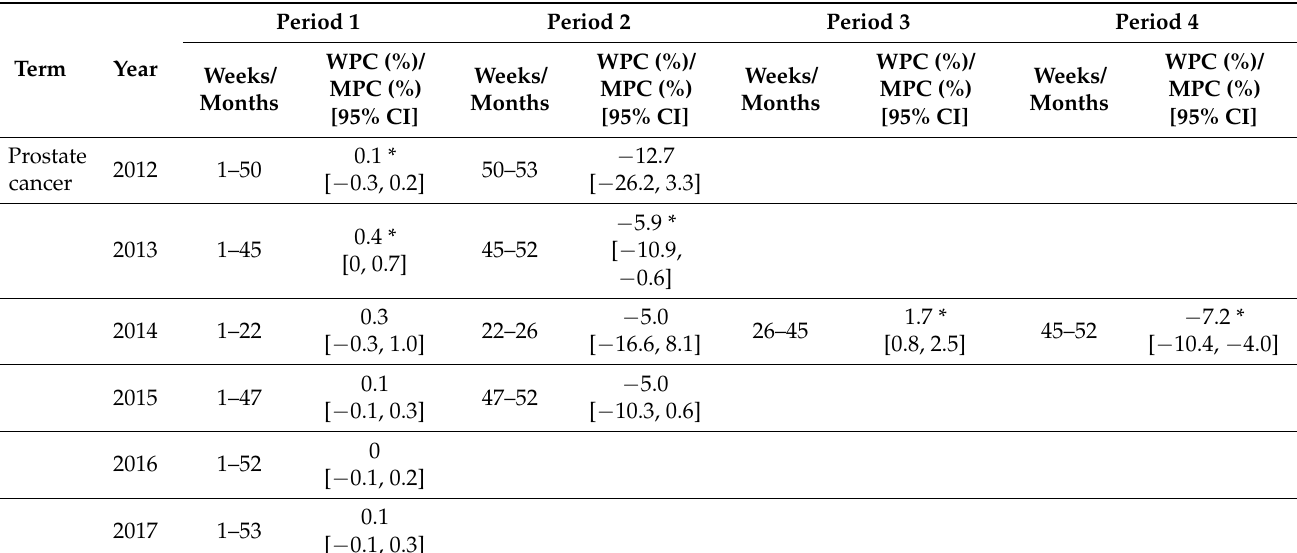
Table 3. Trend changes in relative search volumes of the term “Prostate cancer”